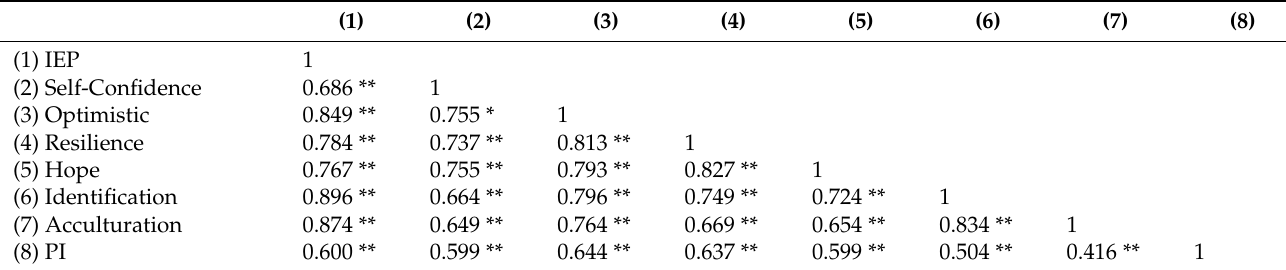
Table 2. Correlation analysis of